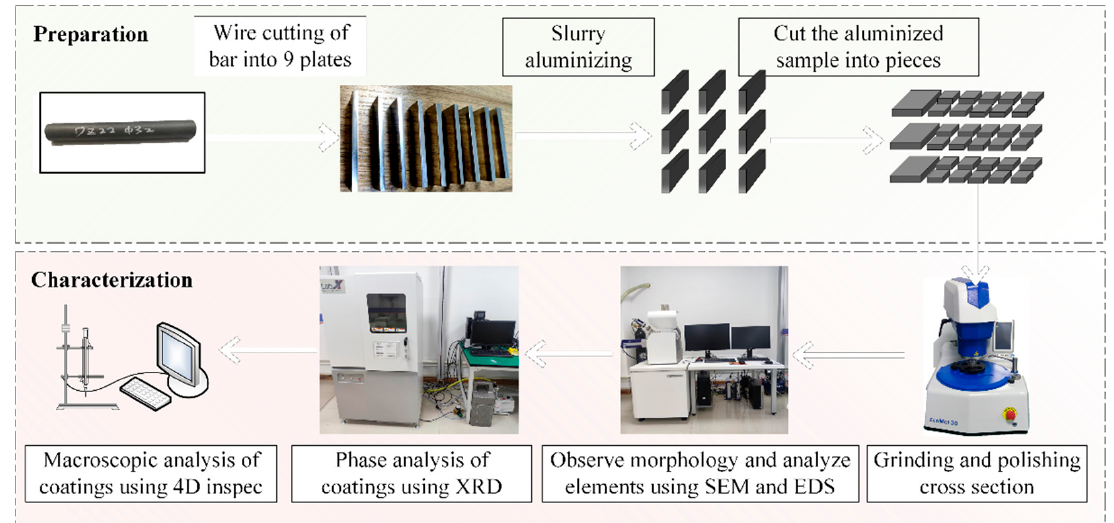
Figure 1. Flow chart of specimen preparation and characterization.